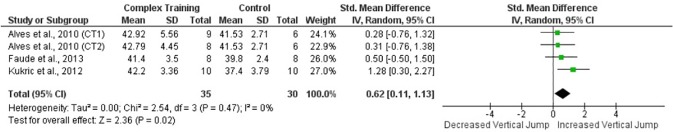
Standardized mean difference (SMD) in post-intervention VJ between CT-trained and control subjects.Squares represent the SMDa for each trial. Diamonds represent the pooled SMD across trials.